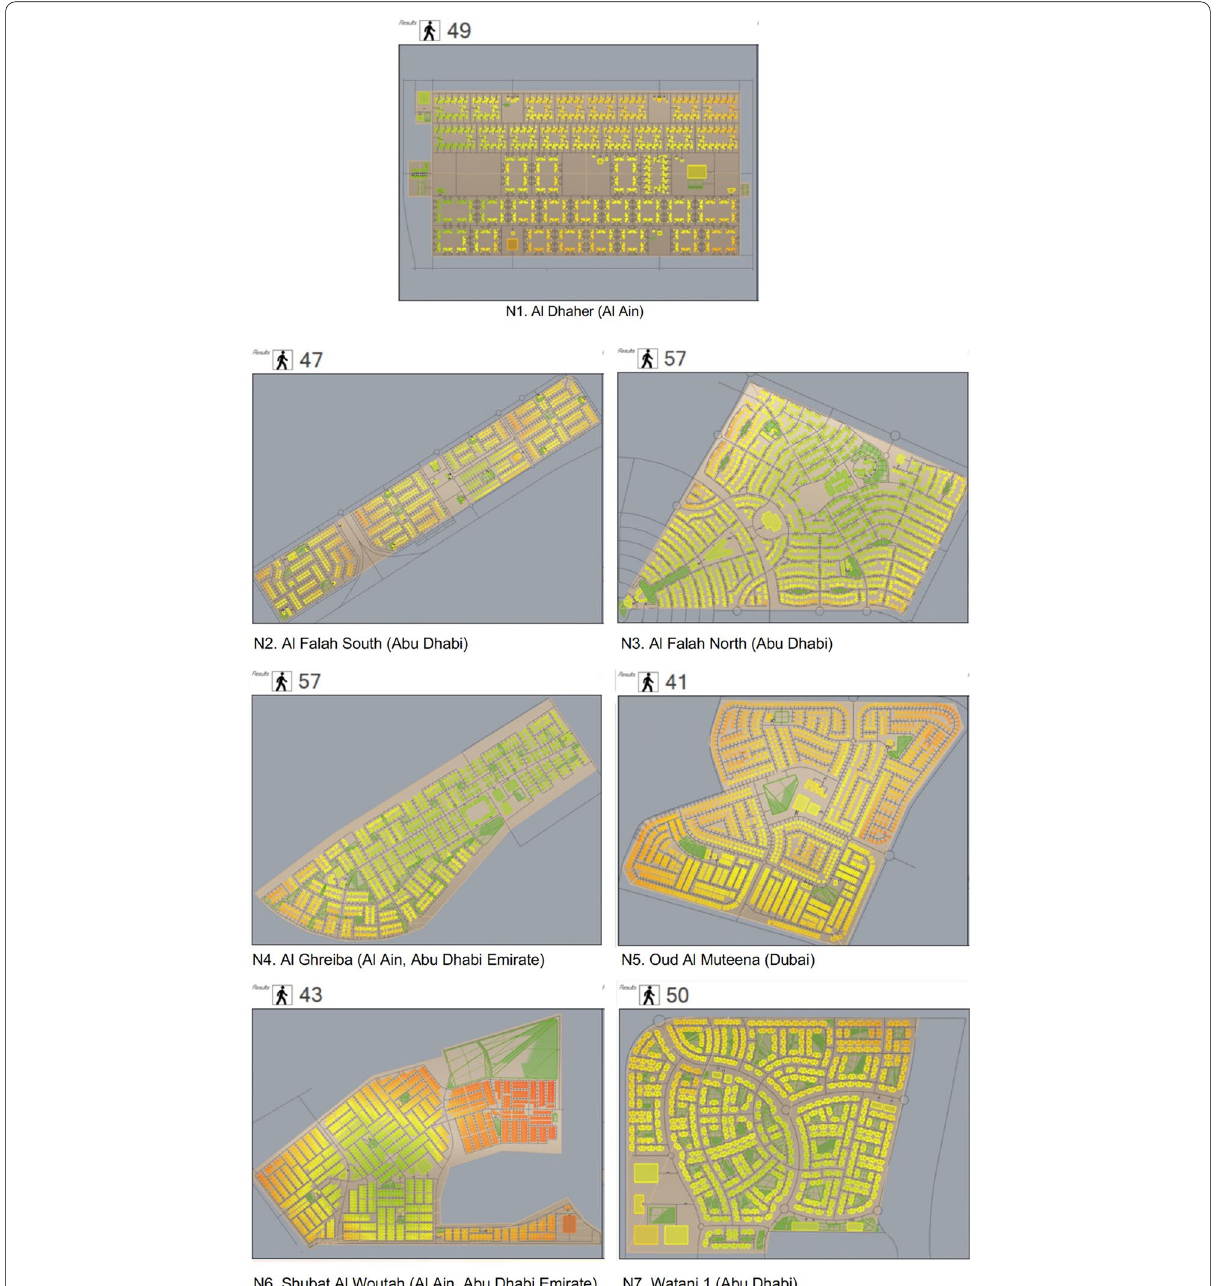
Fig. 7 Visual diagrams for the results of the computational simulations for the average UMI Walkscores for the urban sprawl (N1), and the urban compact case studies (N2–N7) (the greener the color, the better the score)